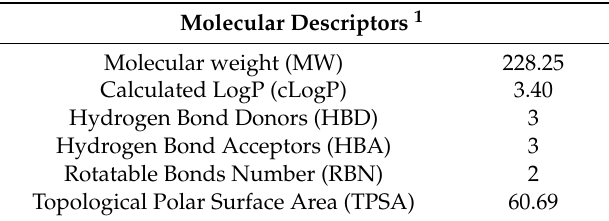
Table 1. Physicochemical properties of trans